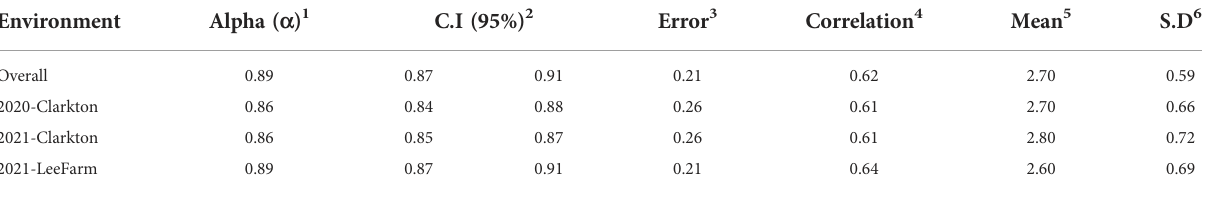
TABLE 1 Summary of Cronbach ’ s alpha ( a ) across testing